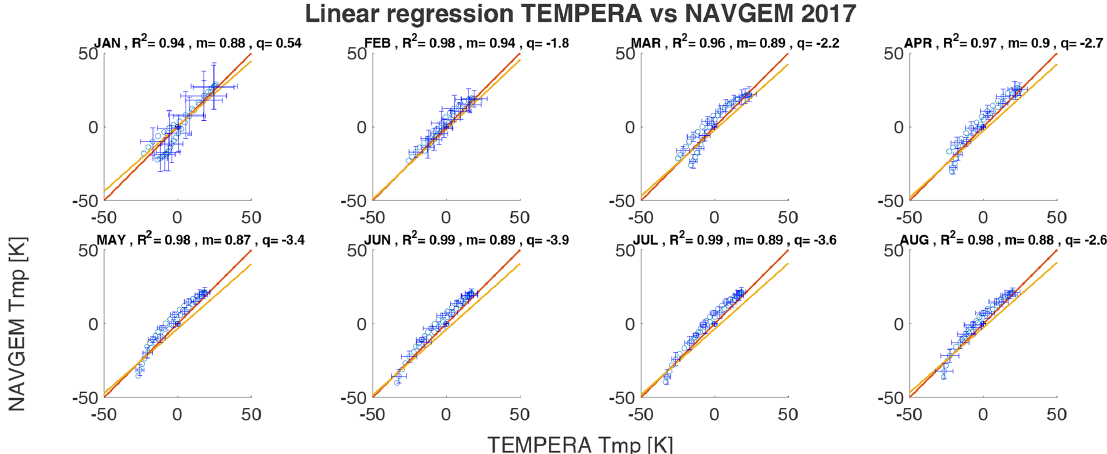
Figure A6. Linear regression of TEMPERA against NAVGE temperatures for the year 2017.